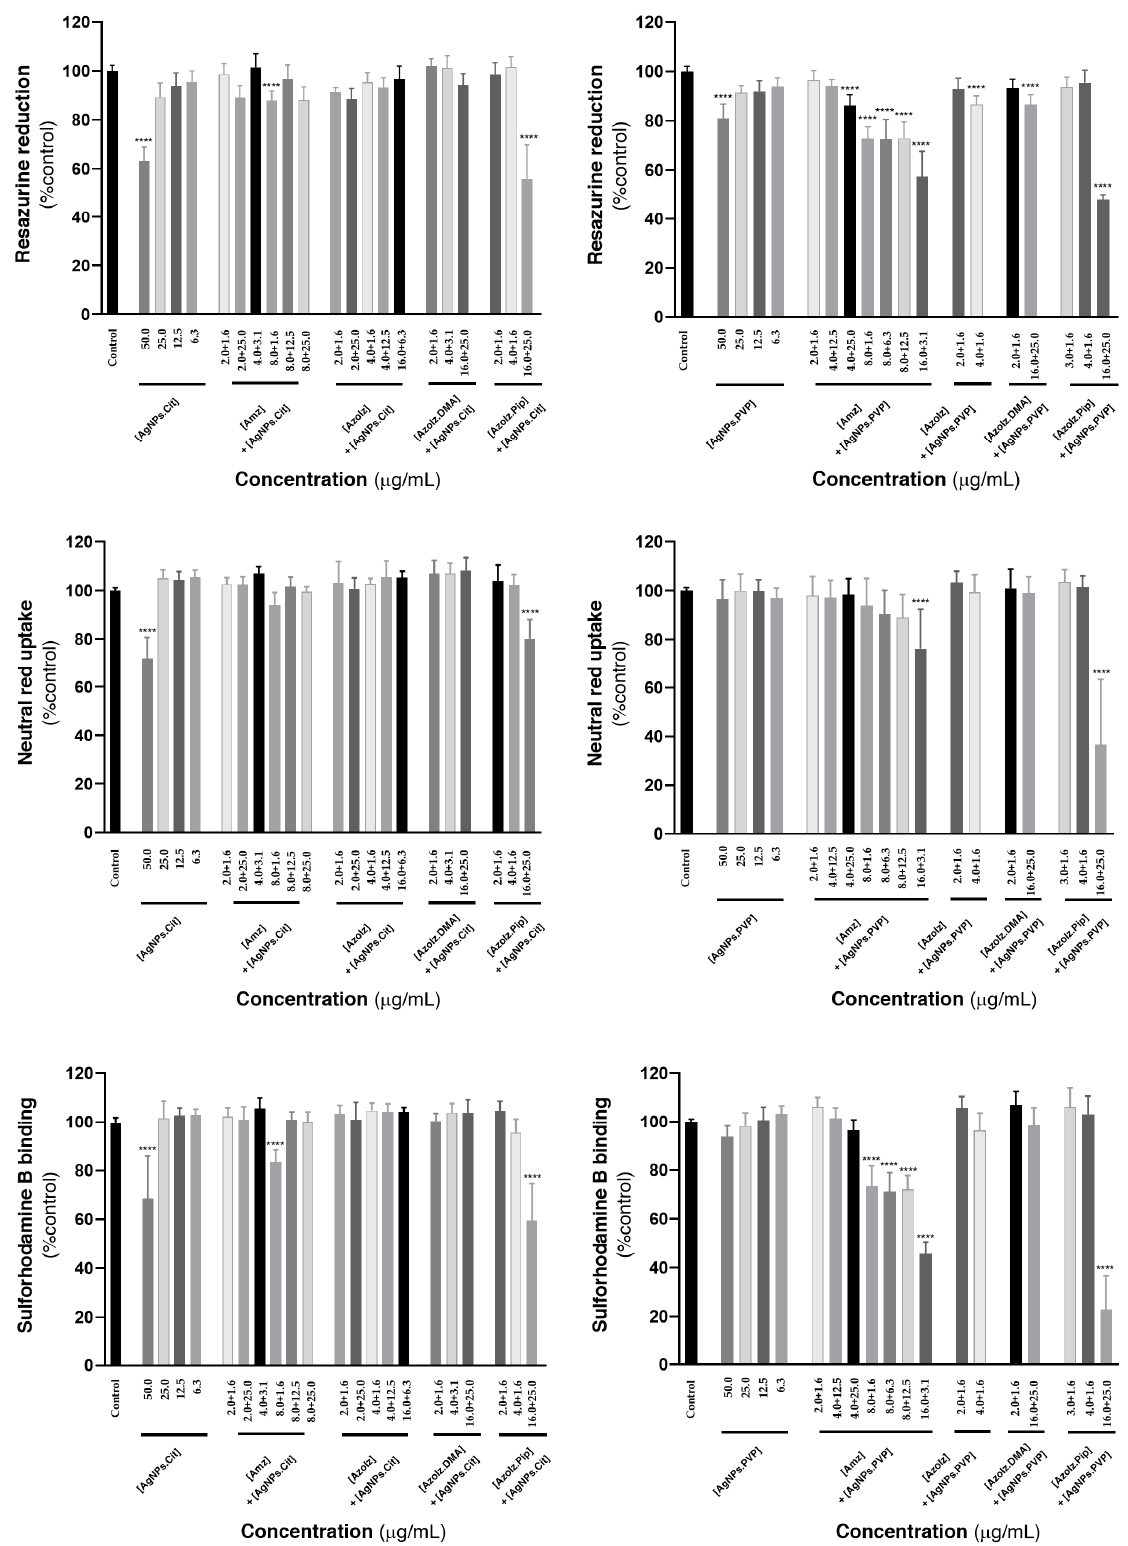
Figure 9. Compounds cytotoxicity towards HaCaT cells, evaluated by the neutral red uptake, resazurin reduction and sulforhodamine B binding assays, 24 h after exposure. Results are expressed as Mean + SD from 4 independent experiments, performed in triplicate. Statistical comparisons were made using one-way ANOVA, followed by Dunnett’s multiple comparisons test (**** p < 0.0001 vs. control).